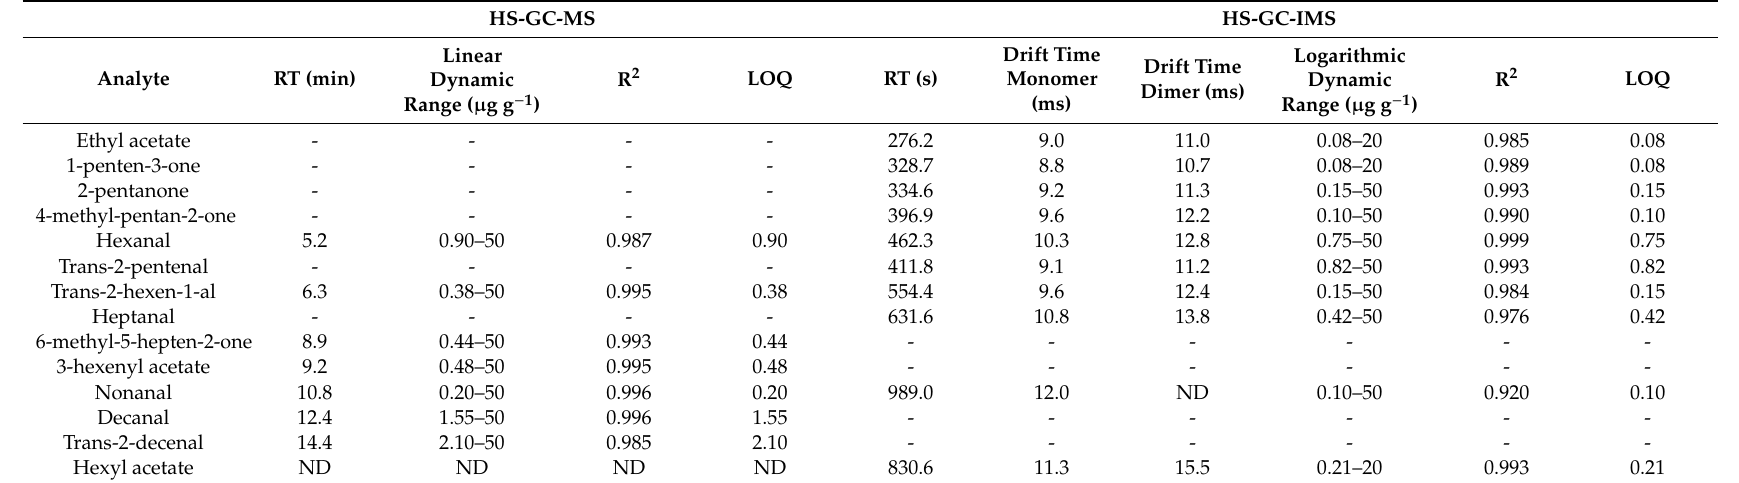
Table 1. Calibration curves and performance characteristics of the headspace-gas chromatography (HS-GC) coupled with mass spectrometry (MS) and ion mobility spectrometry (IMS)